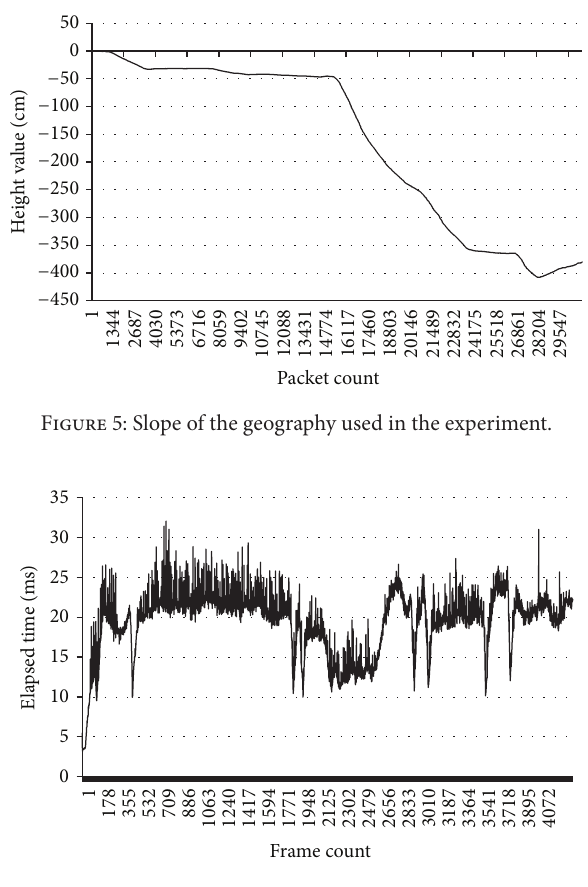
Figure 6: Elapsed time performing segmentation.